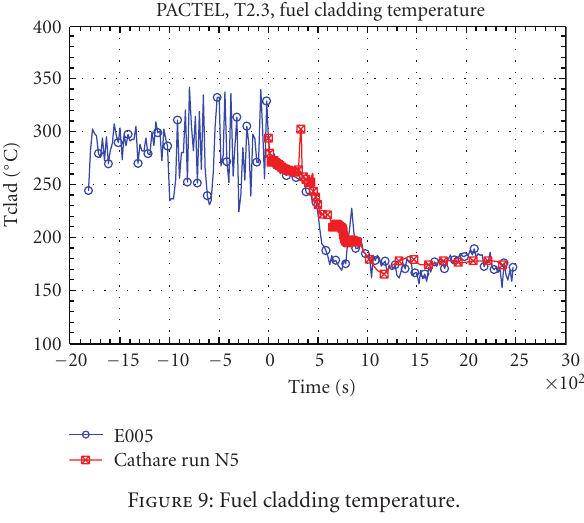
Figure 7: Fuel cladding temperature.